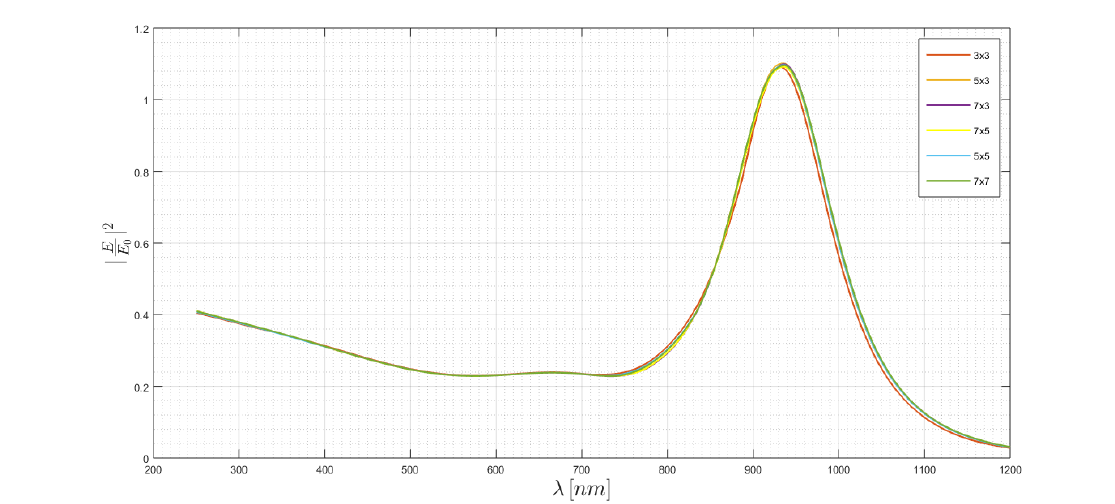
Figure 16. Sweep of the number of holes that composed the gold nanostructure.